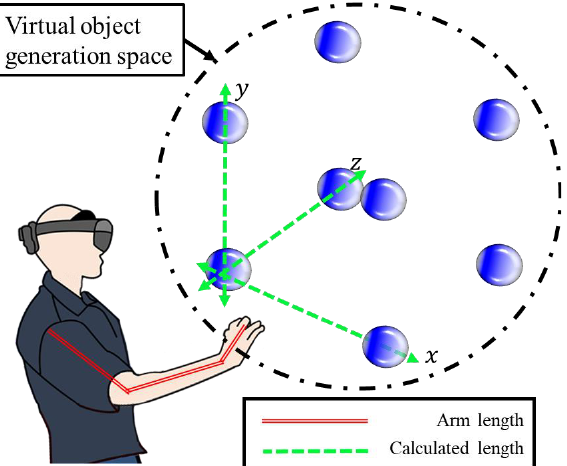
Figure 5. Experimental environment.